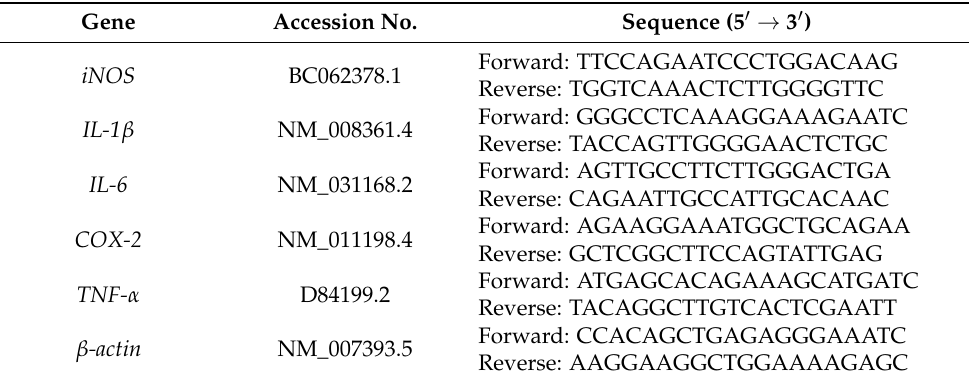
Table 1. The sequences of oligonucleotide primers used in the analysis of immune genes of